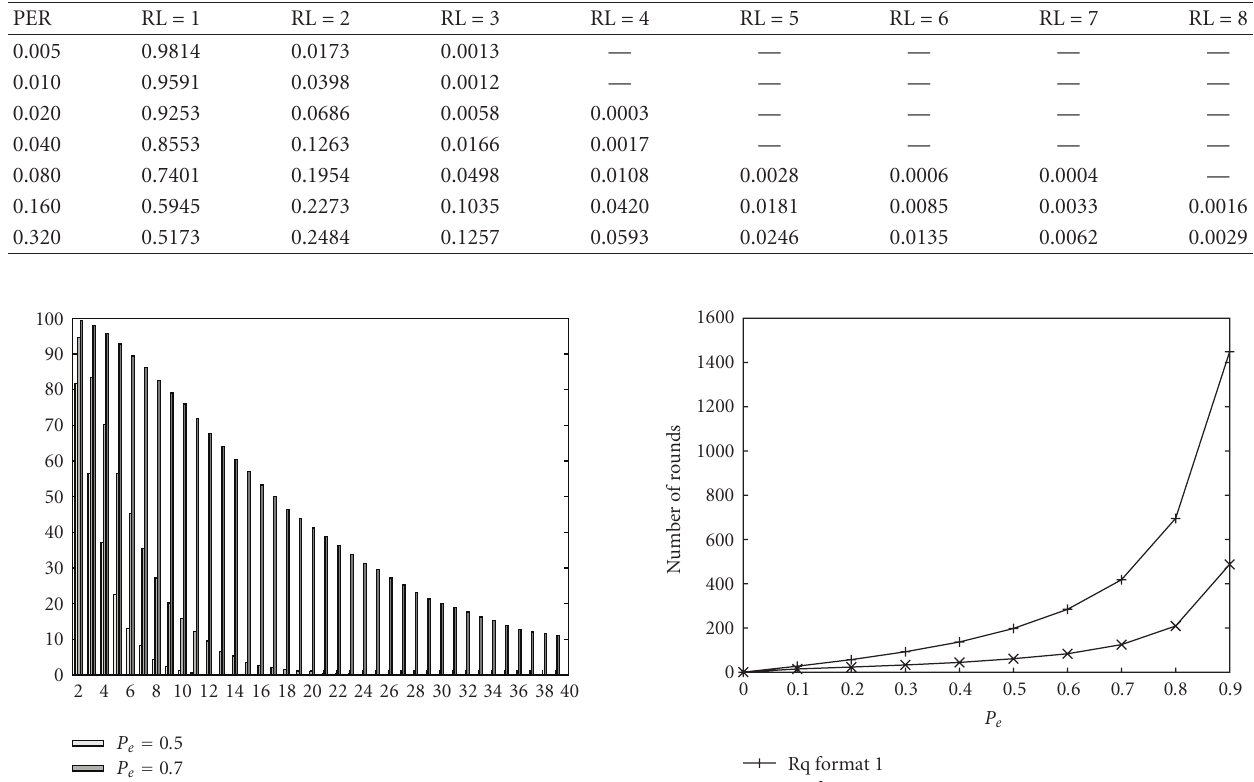
Table 1: Percentage of error runs under random loss.